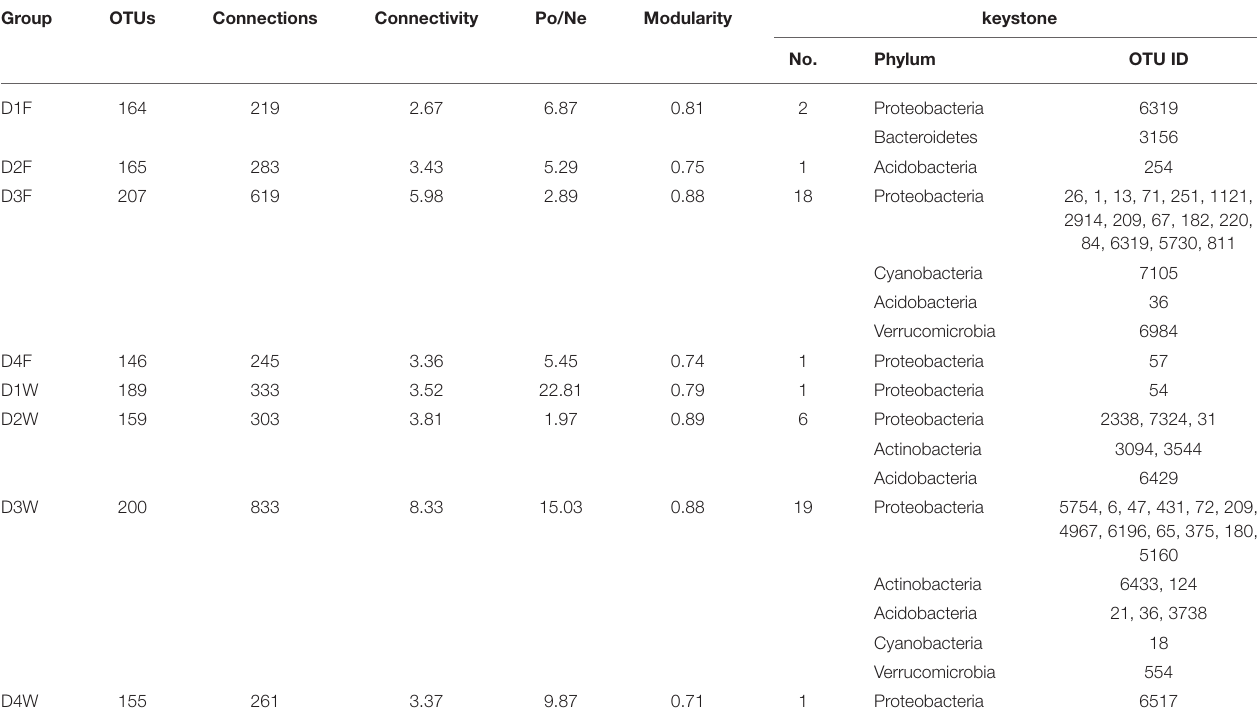
TABLE 2 | Detailed network properties of study groups. Group OTUs Connections Connectivity Po/Ne Modularity keystone